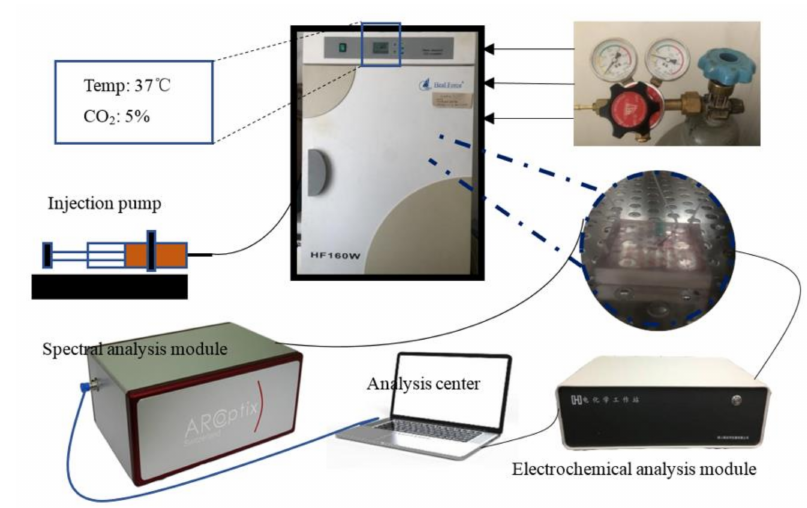
Figure 2. Schematic layout of the liver-on-chip and its analysis system.